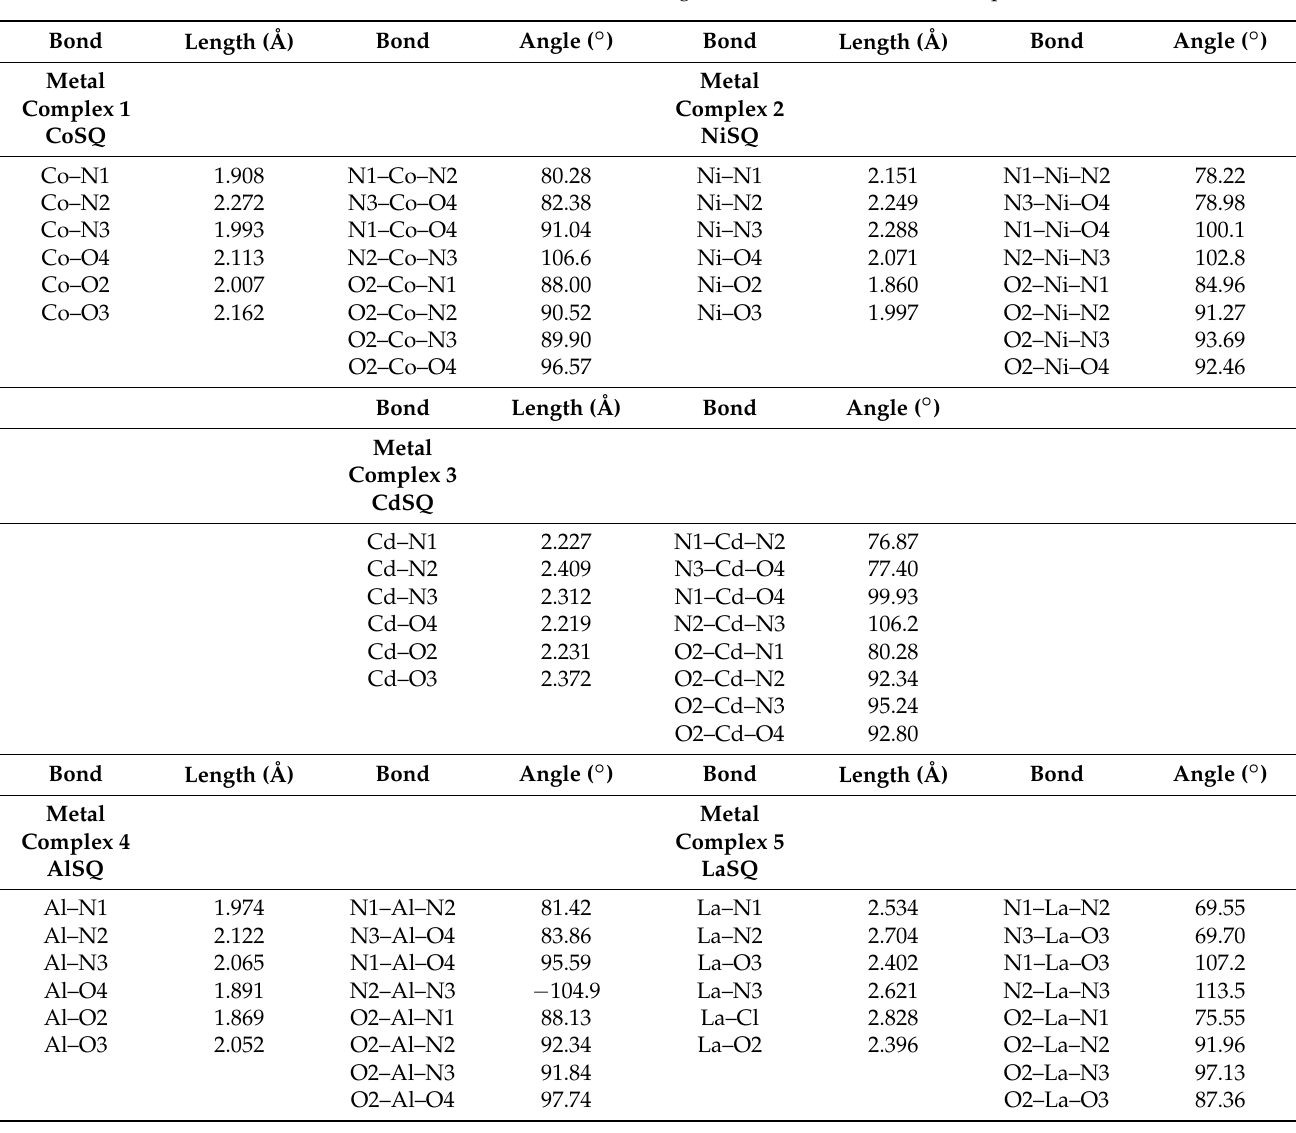
Table 6. Selected bond distances in Å and angles in ◦ of the metal metal